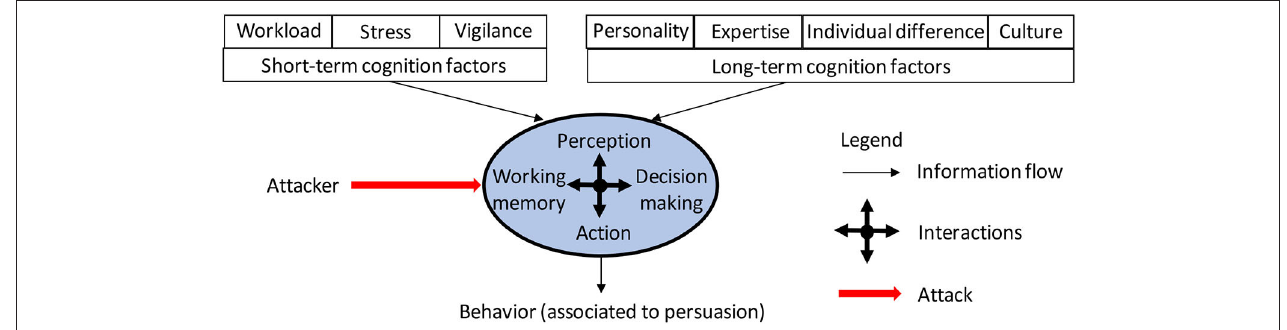
FIGURE 2 | Extending the basic schema of human cognition presented in Figure 1 to accommodate social engineering cyberattacks. The extension is to incorporate an attacker that wages a social engineering cyberattack against a victim’s human cognition functions (i.e., the oval). The resulting behavior is associated to persuasion (i.e., an attack succeeds when a victim is persuaded to act as intended by the